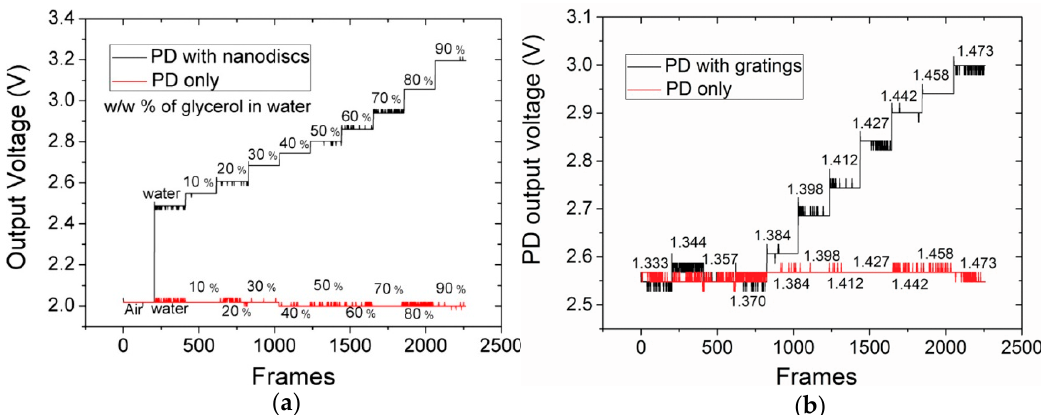
Figure 11. Measured changes in the PD output voltage for various glycerol concentrations as detailed in Shakoor et al. [74,76]. The black staircase curve is the readout from the PD with integrated nanophotonic sensors while the flat red curve corresponds to the readout from the PD with no nanophotonic structures. ( a ) Measured PD voltage for the gold nanodisc array sensor. ( b ) Measured PD voltage from the silicon nitride grating sensor. In (a) the data for the PD output voltage is presented for different concentrations of glycerol while in (b) the data is presented in terms of the refractive indices of different concentrations of glycerol. ( a ) reprinted with permission from [74]. Copyright © American Chemical Society (ACS) (2016). ( b ) reprinted with permission from [76]. Copyright © IEEE (2018).